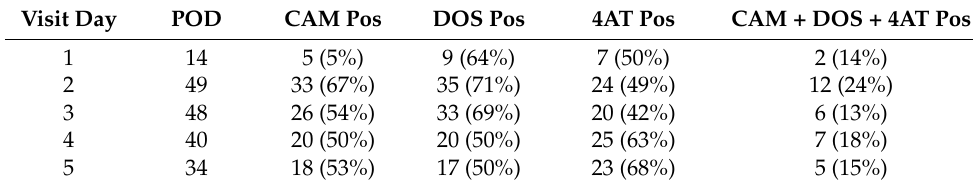
Table 6. Comparison of positive POD tests on normal ward.